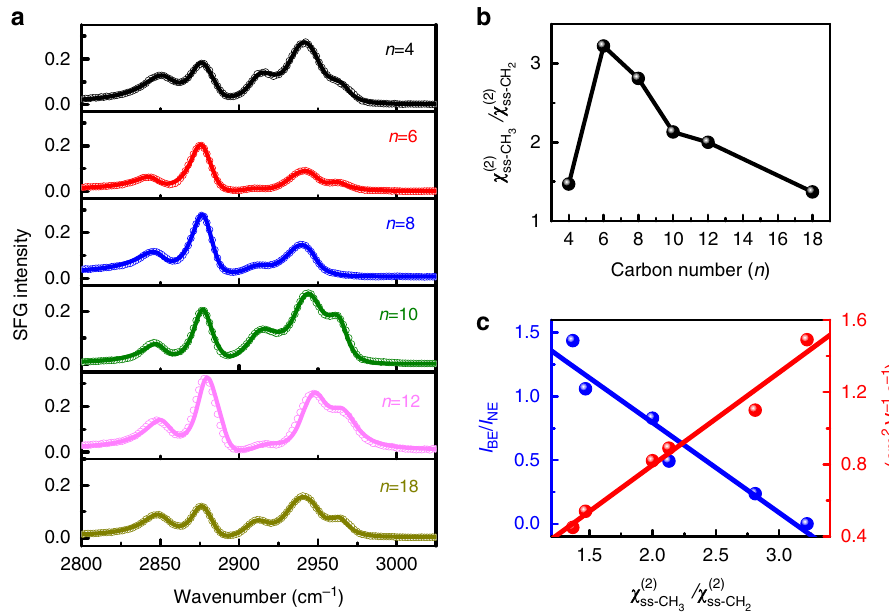
Fig. 3 The structure-property relationship in the 2D OIHP thin fi lms with a thickness of 144 nm. a ssp-polarized SFG spectra of six samples, where symbols represent experimental data while solid lines are fi tted data, respectively. b The χ 2 ð Þ ss (cid:2) cations. c The I BE /I NE ratio at 80K and the in-plane mobility correlate with the χ 2 ð Þ ss (cid:2)